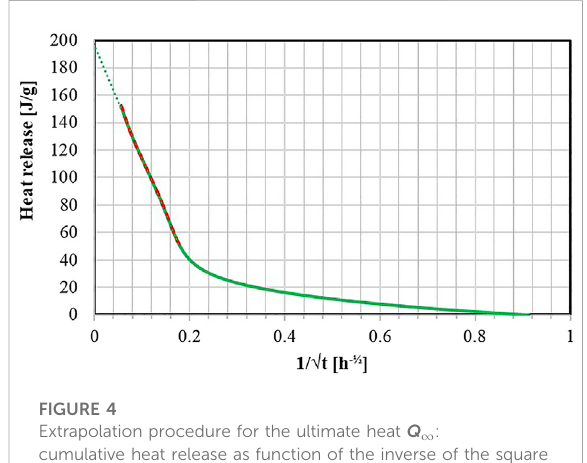
FIGURE 4 Extrapolation procedure for the ultimate heat Q ∞ :